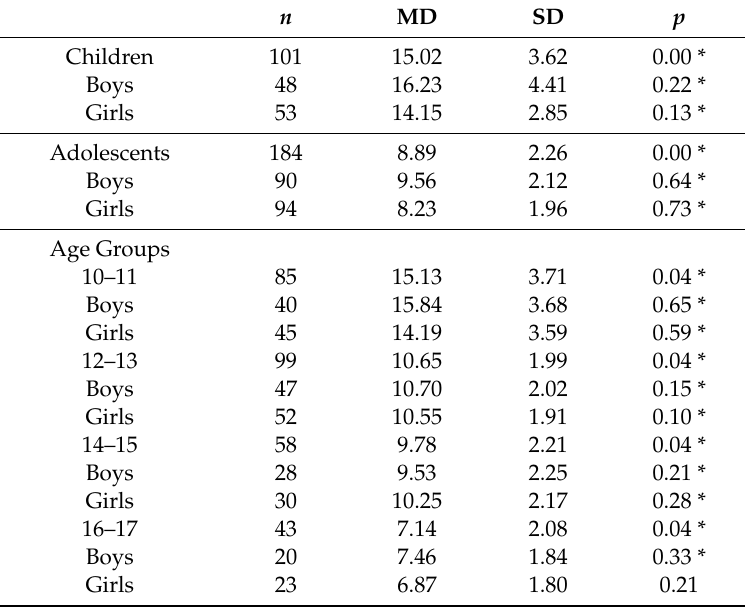
Table 2. Di ff erences in the time spent in the tests by children and adolescents, age groups and gender. n MD